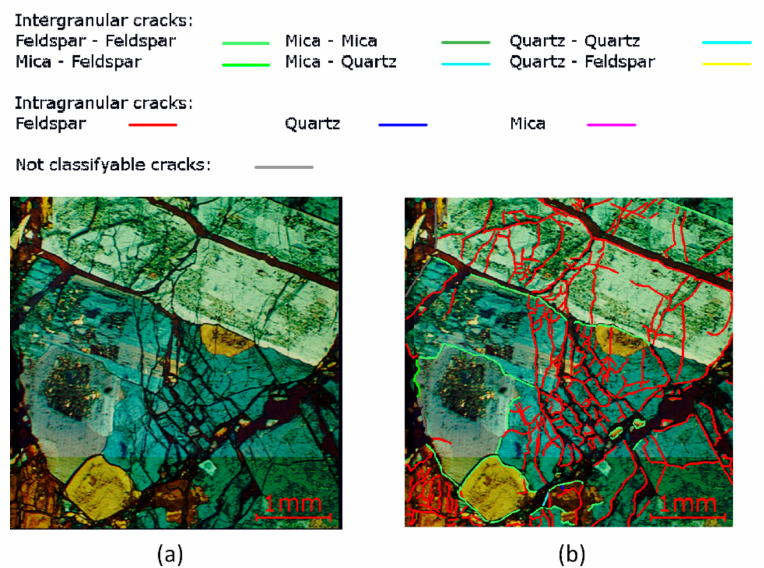
Figure 9. Area with recognizable grain boundary breakages: ( a ) Original view on the fractured microstructure; ( b ) View with highlighted